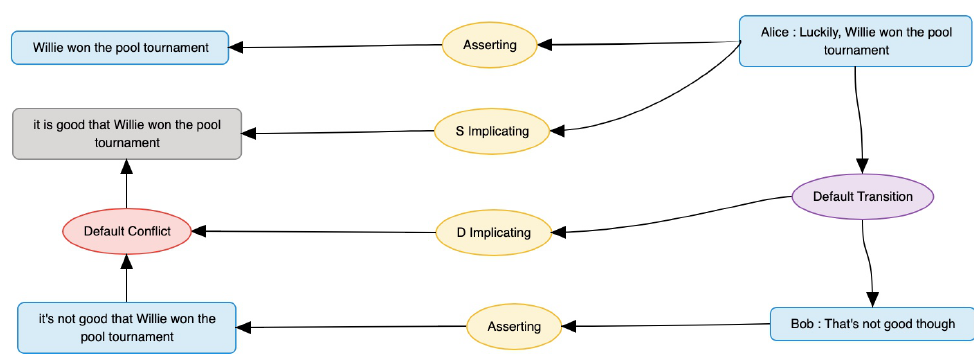
Figure 2. IAT CI diagram for Example (12) with CI